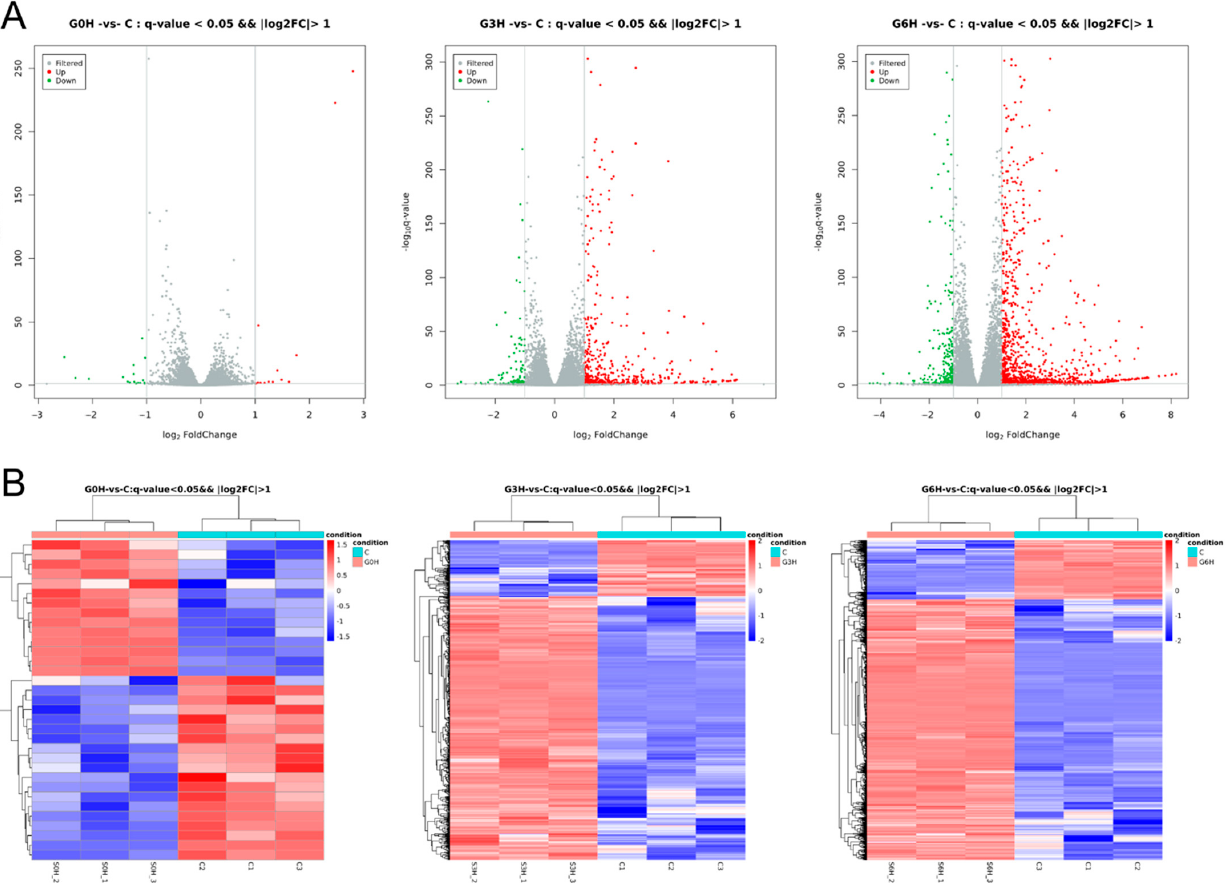
Figure 2. Time series transcriptomic changes of electroporation-induced apoptosis revealed gradually widespread gene expression differences. ( A ) Volcano plots for showing time series differentially expressed genes ( q -value < 0.05 and foldchange > 2 or foldchange < 0.5). ( B ) Heat maps for displaying hierarchical cluster analysis of time series differentially expressed genes.